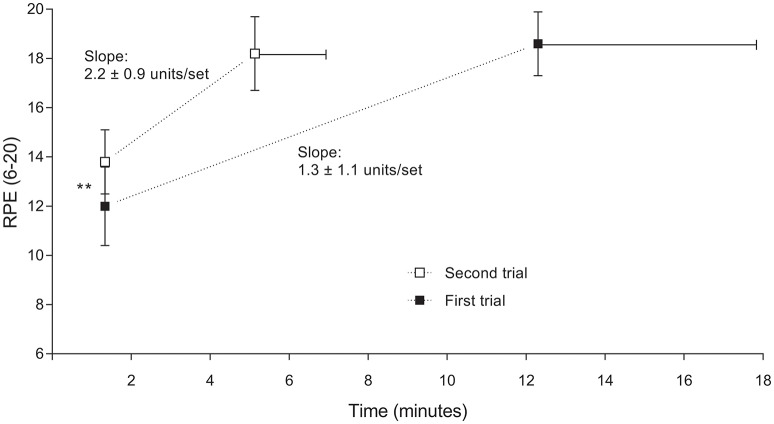
Changes of ratings of perceived exertion (RPE) during the first and second trial, from the first to the last completed contraction set. Data are shown as mean ± SD, n = 10. Significant difference between first and second trial: **
P < 0.01. RPE during the last set was not different (P = 0.517) between trials.